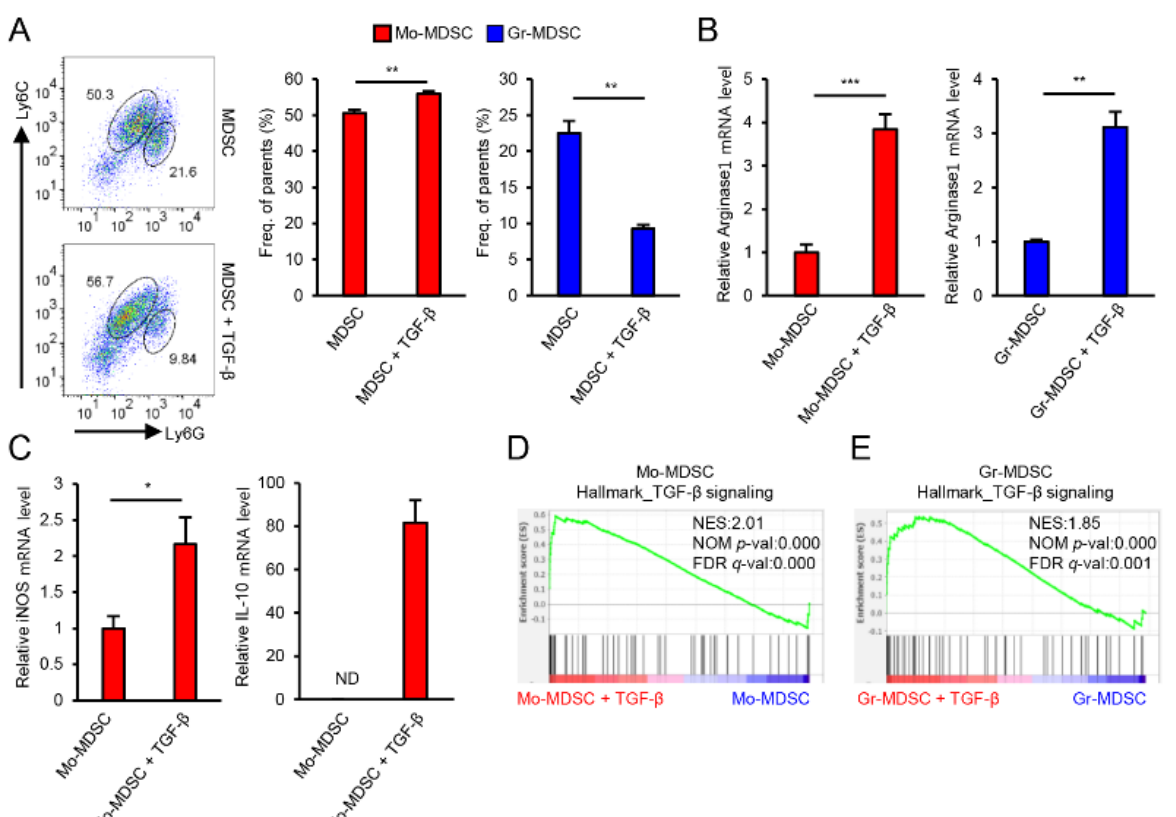
Figure 1. TGF- β increases the immunosuppressive function of MDSCs. ( A ) Representative FACS plots of MDSCs subpopu- lations [Mo-MDSCs (Ly6G low Ly6C high ) and Gr-MDSCs (Ly6G high Ly6C low )] and bar graphs showing the percentages of each subpopulation. ( B ) The level of arginase1 mRNA in Mo-MDSCs and Gr-MDSCs after TGF- β treatment. ( C ) iNOS and IL-10 mRNA levels in Mo-MDSCs after TGF- β treatment under lipopolysaccharide (LPS) stimulation condition. ( D ) GSEA analysis of microarray data from Mo-MDSCs treated with TGF- β . ( E ) GSEA analysis of microarray data from Gr-MDSCs treated with TGF- β . Data are expressed as the mean ± SD. ND, not detected. * p < 0.05, ** p < 0.01, and *** p < 0.001 by two-tailed t -test.